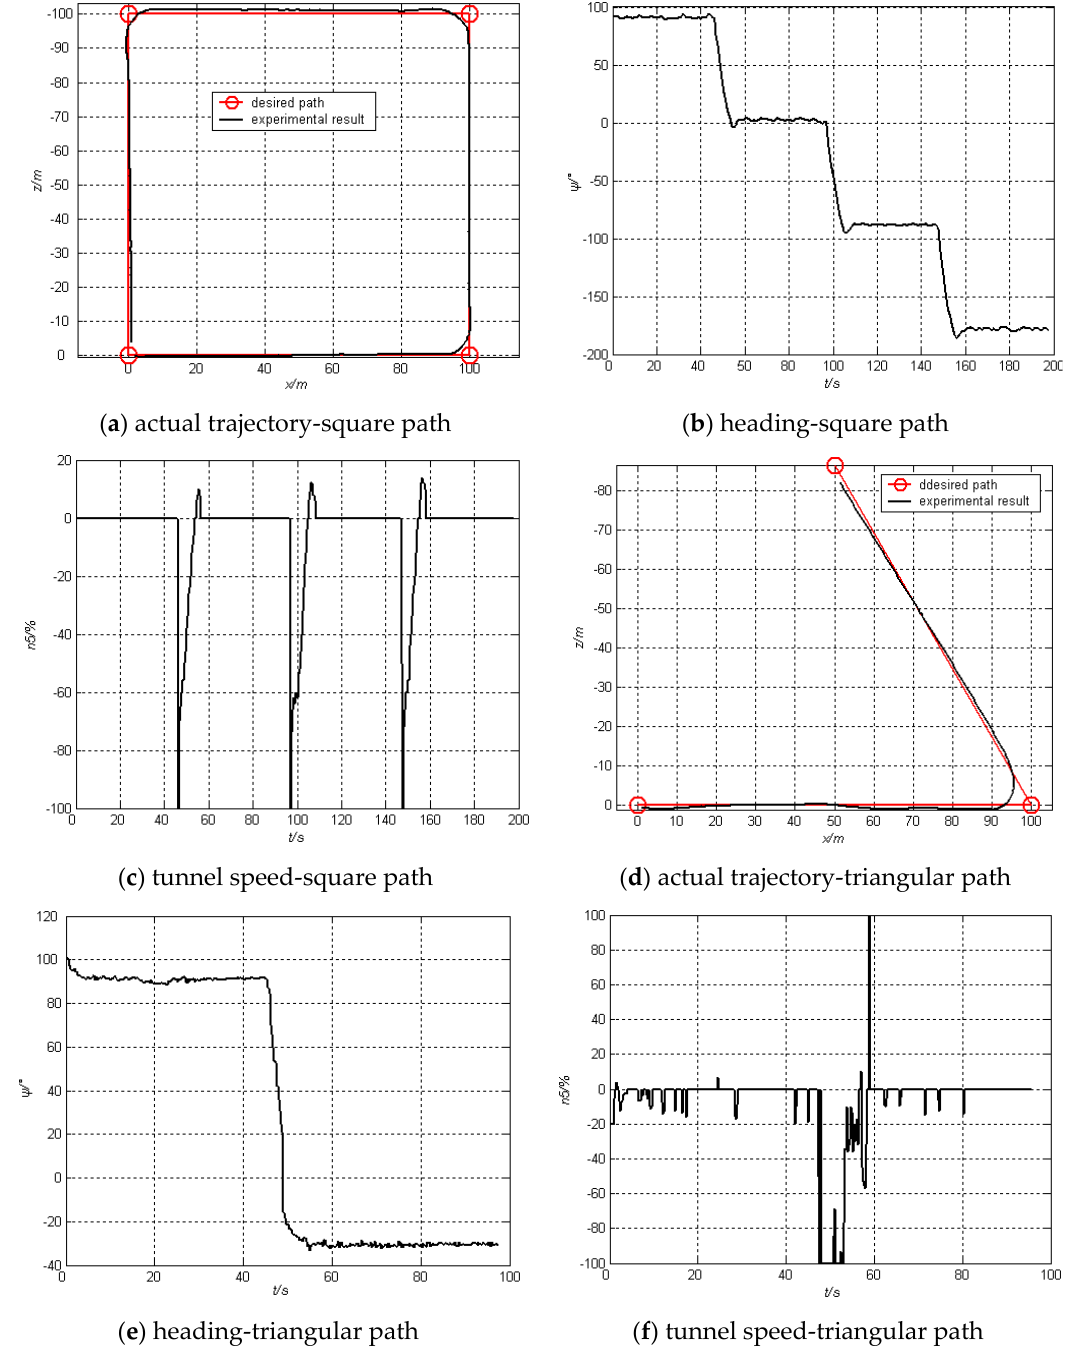
Figure 32. Path following experiment with modified LOS.